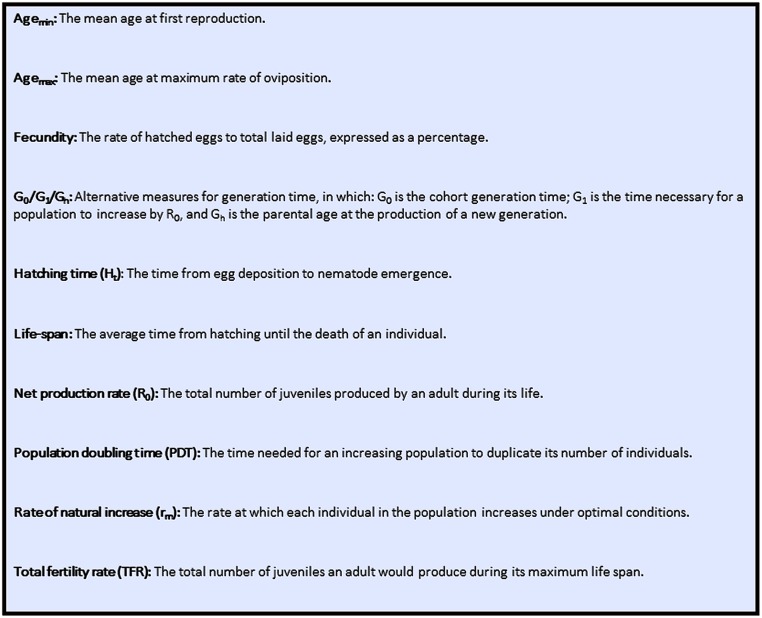
Glossary of terms.